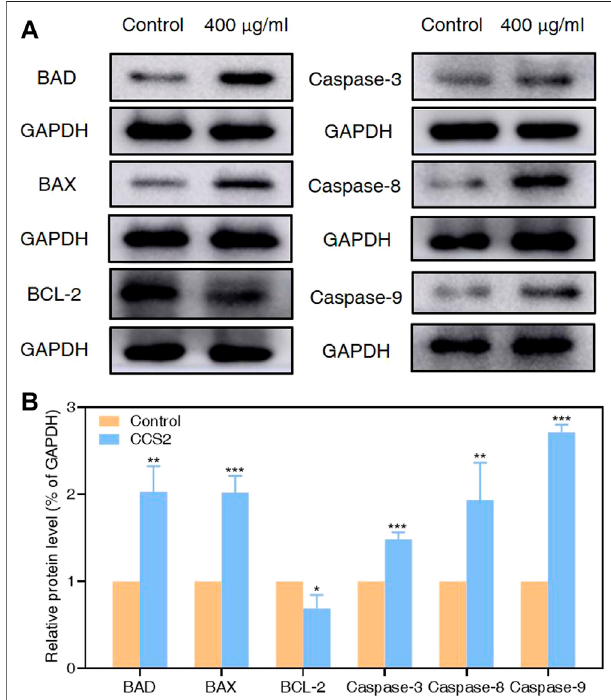
FIGURE 7 | Relative protein expression of apoptosis-related proteins in AGS cells by western blotting analysis. Through western blotting analysis, the effect of CCS2 treatment on the protein expression of BAD, BAX, BCL-2, Caspase-3,Caspase-8andCaspase-9wasdetermined. (A) Expression of apoptosis-related proteins was determined. (B) The histogram represents relative protein levels normalized to GAPDH for BAD, BAX, BCL-2, Caspase- 3, Caspase-8 and Caspase-9. Data are expressed as the average of three independent experiments. Data are expressed as the average of three independent experiments. * p < 0.05, ** p < 0.01, *** p < 0.001 compared with